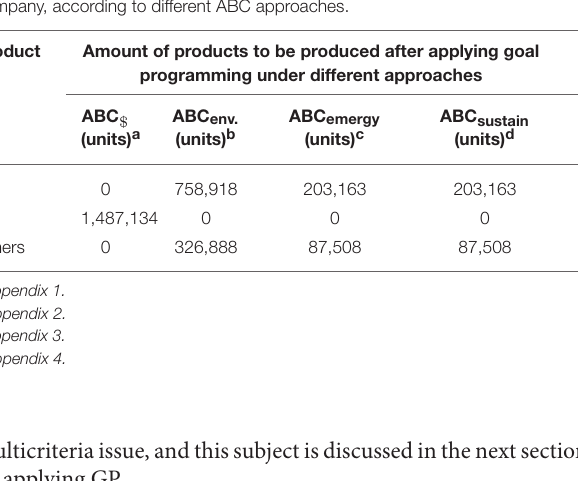
TABLE 4 | Amount of products that should be produced by the studied generic company, according to different ABC